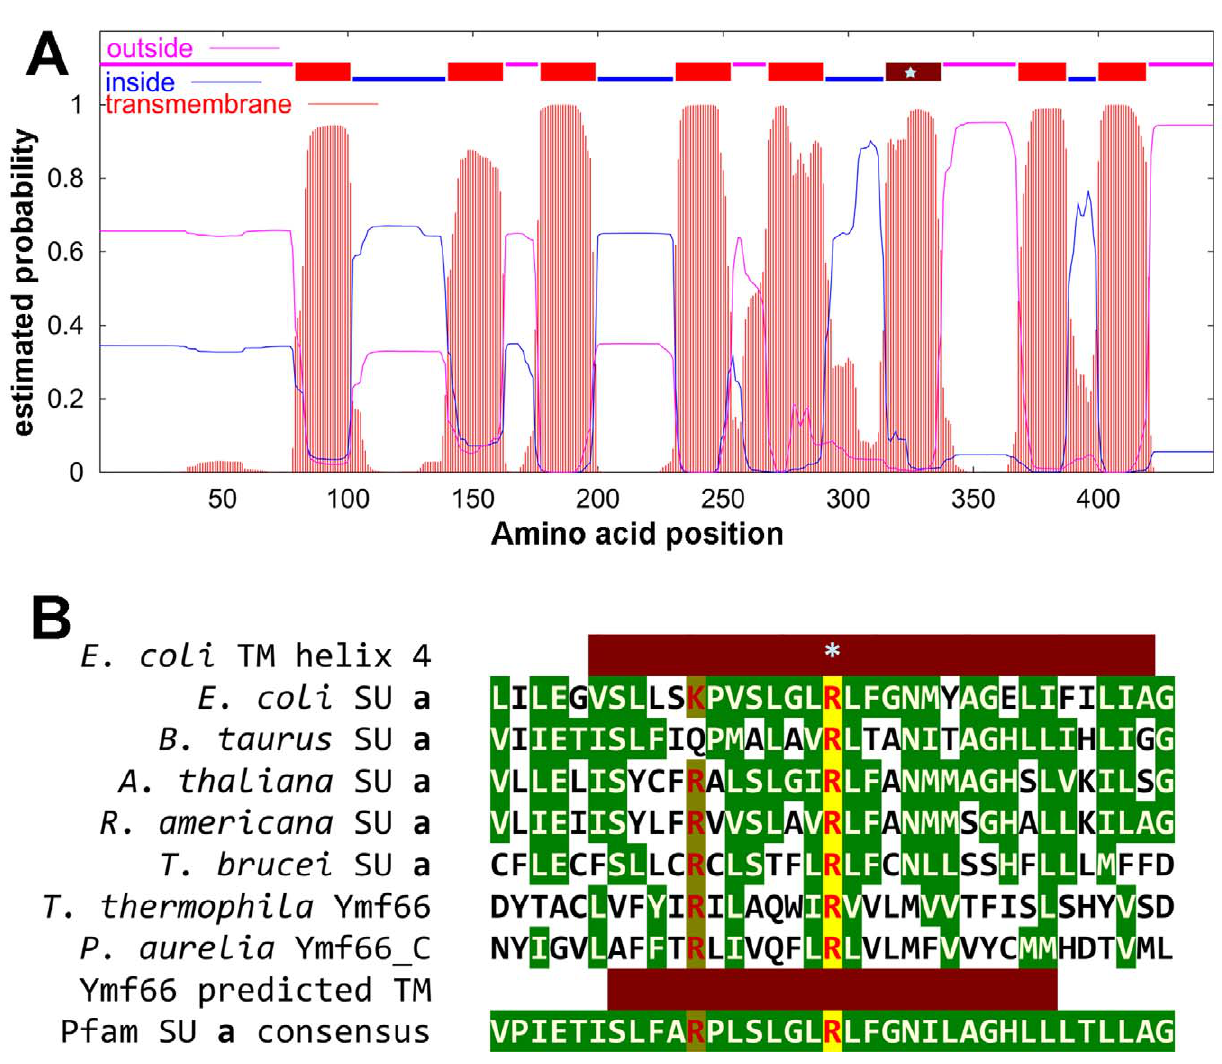
Figure 4. Position of arginines in putative TM6 of Ymf66 and possible alignment with the region of ATP synthase subunits a that contains the conserved Arg. (A) Prediction of transmembrane helices and topology by TMHMM (similar results are obtained with other algorithms). The predicted extent of transmembrane segments is indicated by red bars above the plotted probability scores; the sixth transmembrane segment containing two Arg residues is colored dark red with a star at the position of the second Arg. (B) An alignment of Ymf66 transmembrane helix 6 with the region of ATP synthase subunits a that contains an essential conserved Arg. Residues that are identical to or chemically similar to the consensus amino acid are shown with reverse green coloration; the conserved Arg is shown in red and highlighted with yellow background, and the second partially conserved Arg is shown in dark red with yellow-green background. The extent of known ( E. coli ) and predicted (Ymf66) transmembrane helices is indicated by dark red bars. Sequence data: E. coli , gi:16131606; B. taurus , gi:60101830; A. thaliana , gi:6851018, R. americana , gi:2258385; T. brucei , gi:343544; T. thermophila , gi:15027631; P. Aurelia , gi:8928578.